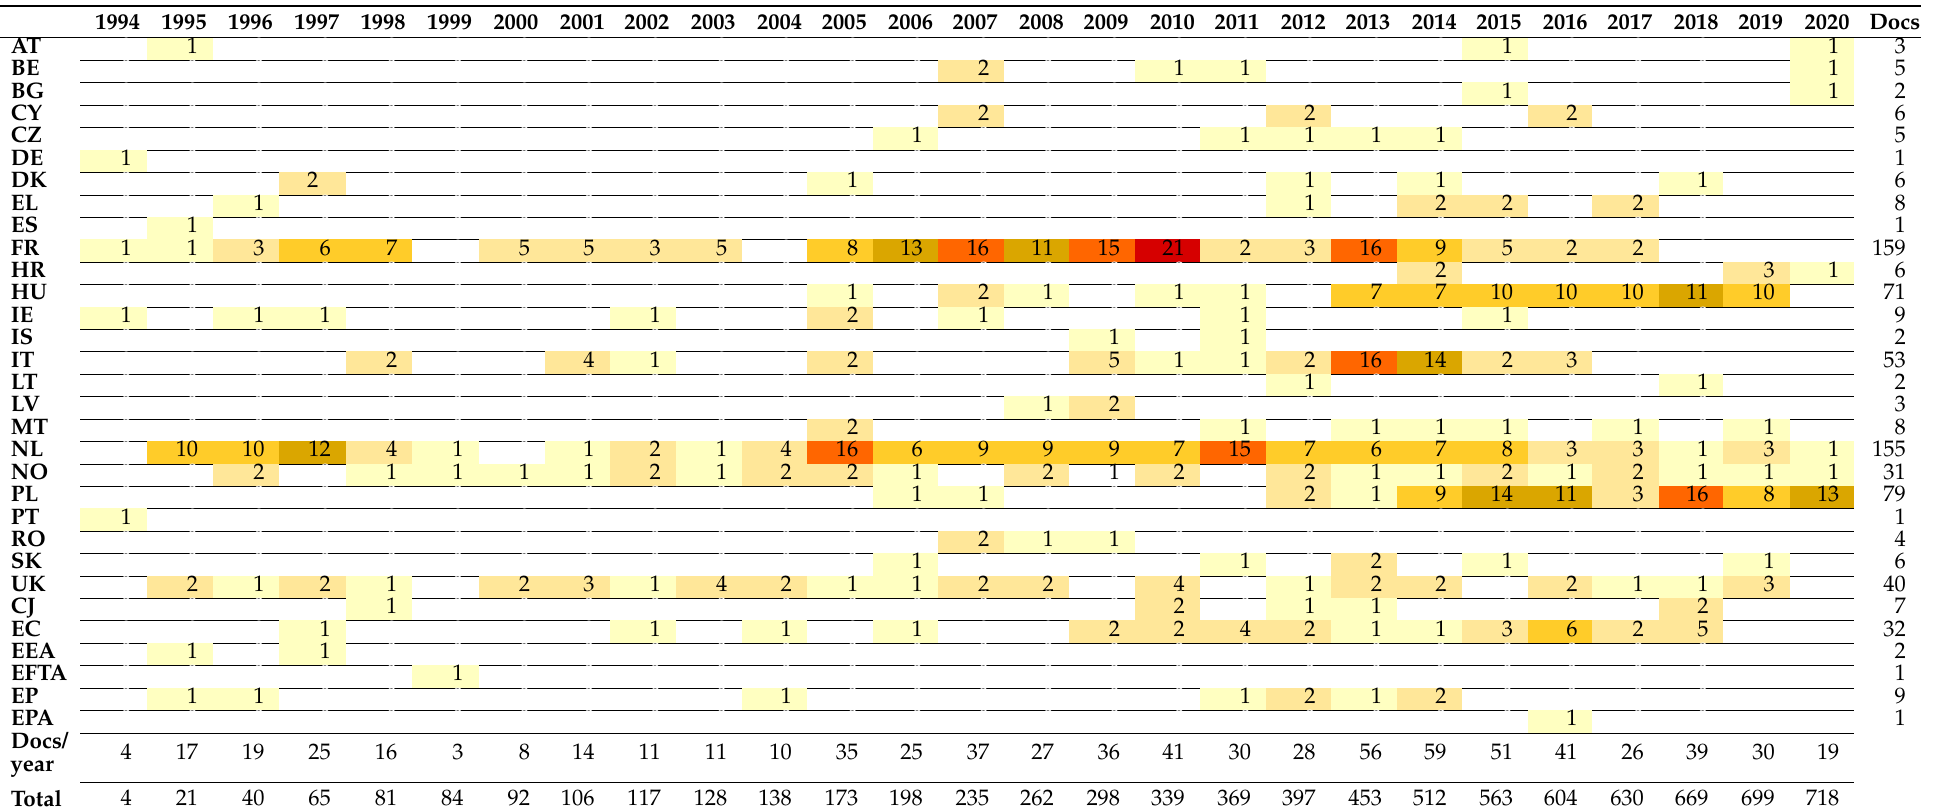
Table 3. Annual publishing activities and total number of published documents between 1994 and 2020. Data source: